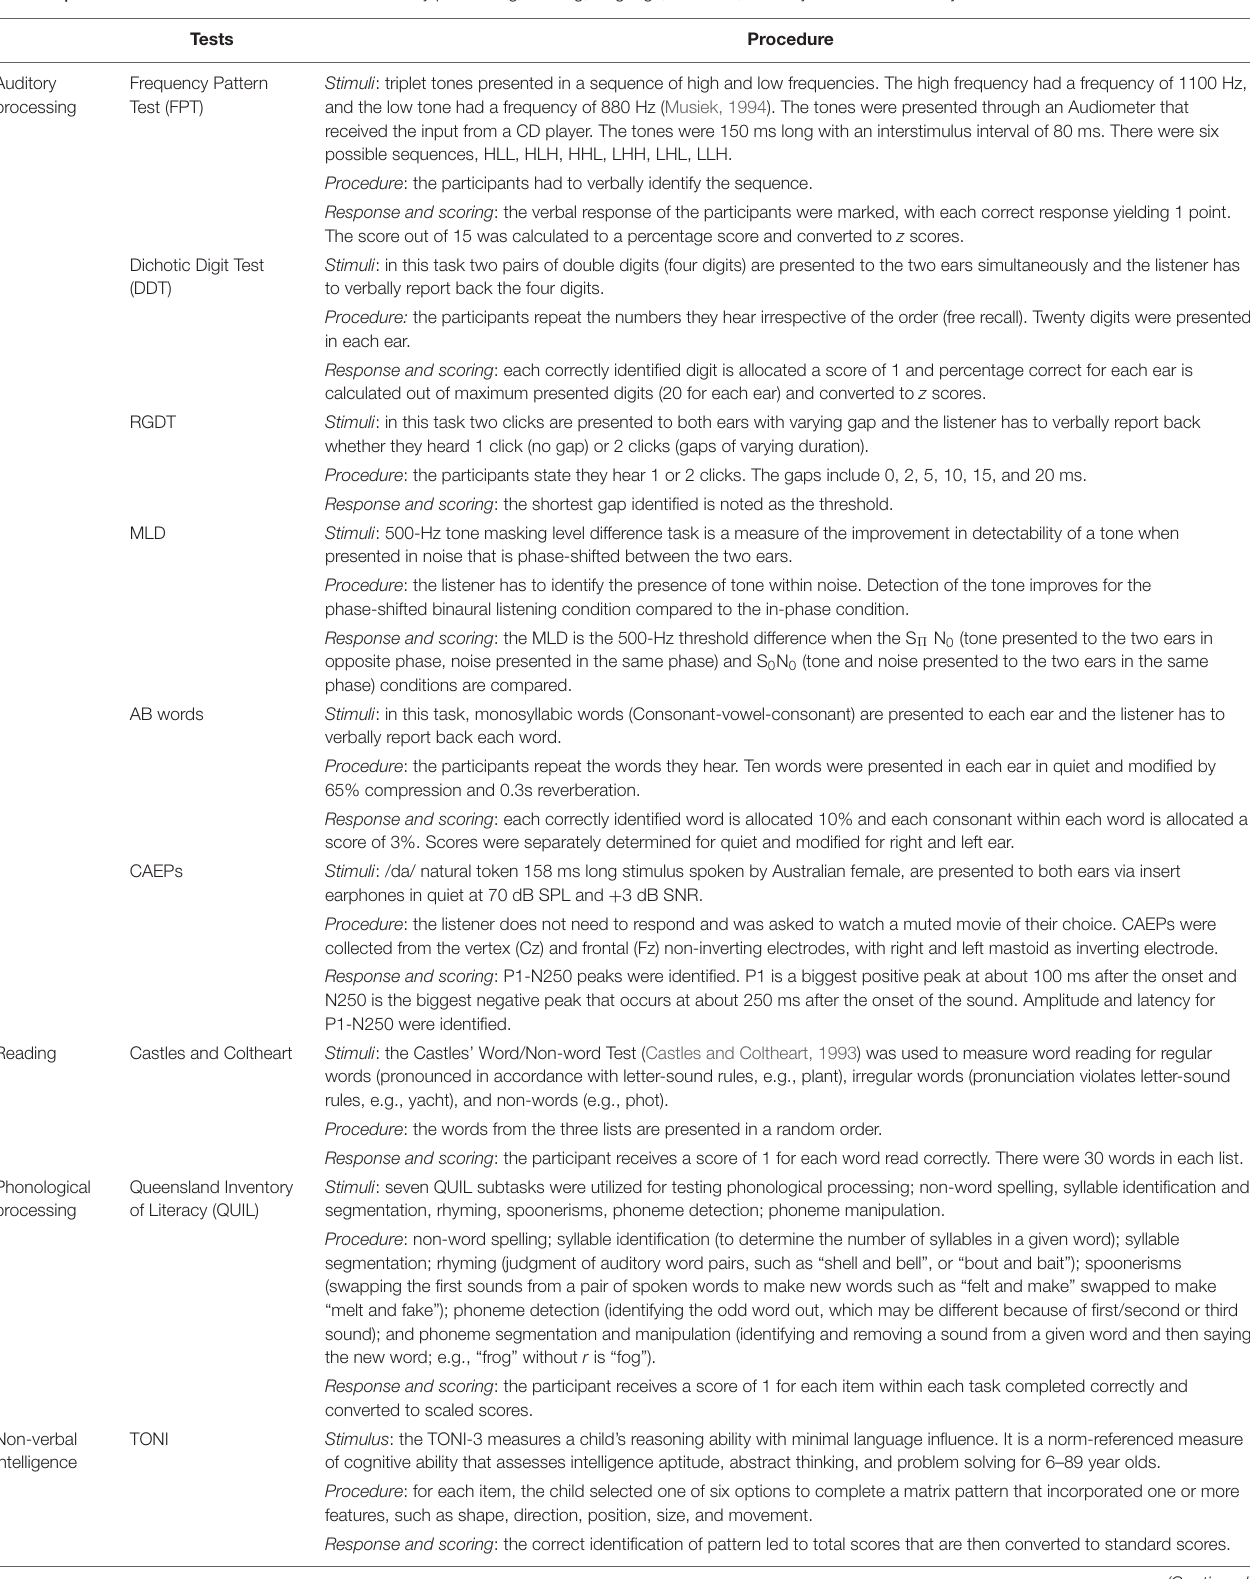
TABLE 1 | The details of the all tests that included auditory processing, reading, language, attention, memory in the current study. Tests Procedure Auditory Frequency Pattern processing Test